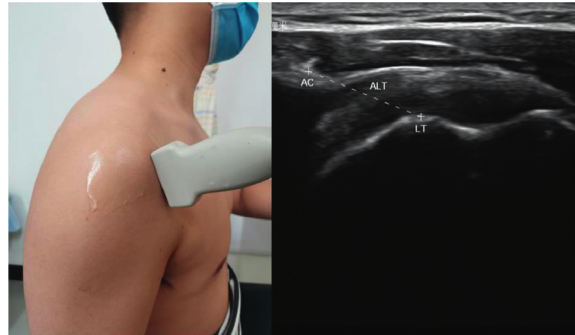
Figure 3: Measurement of acromion-lesser tuberosity (ALT) for shoulder subluxation by using musculoskeletal ultrasound imaging technique. AC indicates acromion; LT indicates lesser